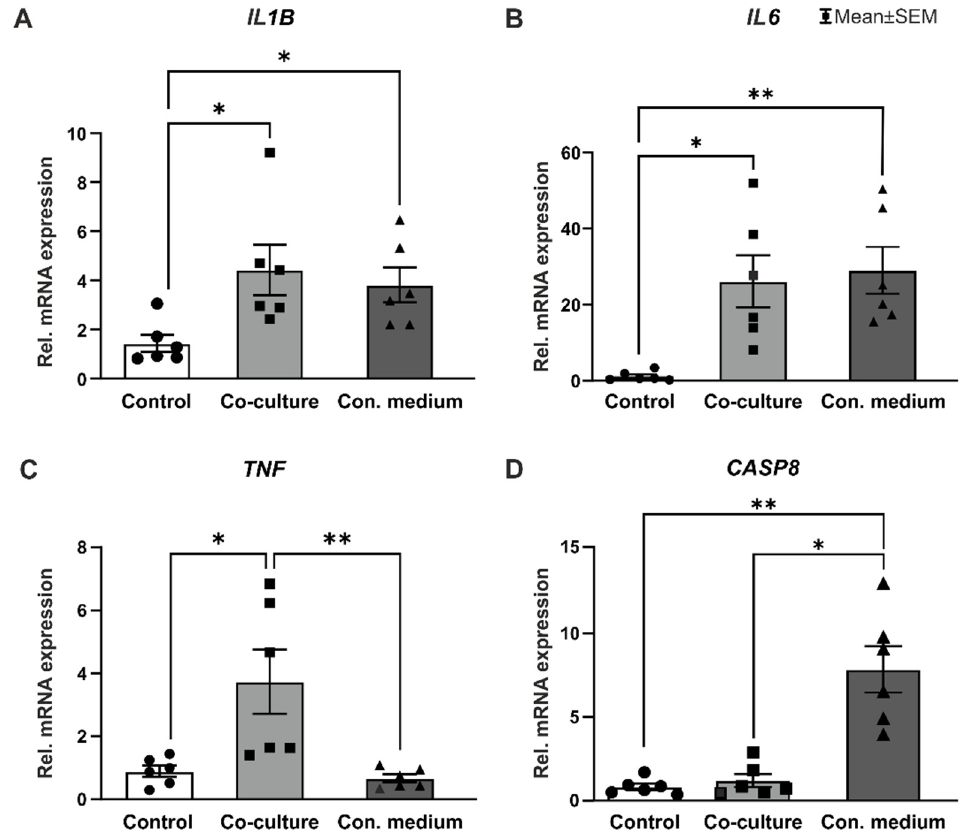
Figure 7. Co-cultivation with ppRPE leads to the upregulation of pro-inflammatory cytokines. ( A ) Relative mRNA expression of IL1B was significantly enhanced in co-culture ( p = 0.028) and conditioned medium samples ( p = 0.045) compared to the control group. ( B ) IL6 mRNA expression was significantly increased in co-culture ( p = 0.018) and medium ( p = 0.006) groups compared to control. ( C ) In co-culture group, relative mRNA expression of TNF was significantly upregulated compared to control ( p = 0.039) and medium ( p = 0.004) samples. ( D ) CASP8 mRNA expression was significantly increased in medium group compared to control ( p = 0.006) and co-culture group ( p = 0.018). Values are presented as mean ± SEM, n = 6/group, * p < 0.05, ** p < 0.01.